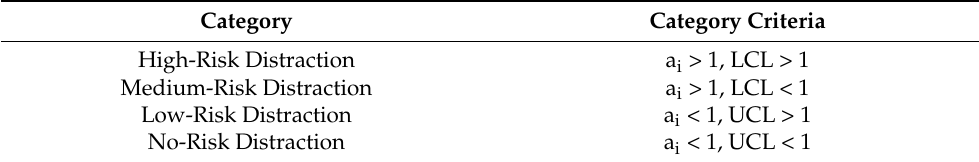
Table 4. Secondary driving task category criteria.